Question: Condense the content of this figure into a single sentence.
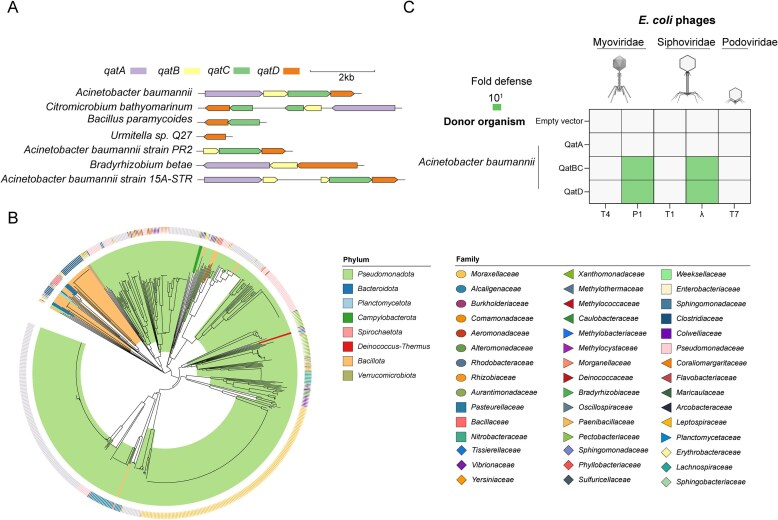
Answer: Qat anti-phage system is widespread. ( A ) The distribution and arrangement characteristics of the qat gene cluster and the scale bar (2 kb) denotes the length range of the gene cluster. Visualization was performed using ChiPlot ( https://www.chiplot.online/ ). ( B ) The phylogenetic analysis results of QatD homologs across representative bacterial species. This circular phylogenetic tree uses sector colors to distinguish bacterial Phylum, while the color bars at the branch termini correspond to the more refined family (different colors and symbols in the legend denote phylum and family). ( C ) Heatmap showing fold defense of E. coli expressing Qat components (empty vector, QatA, QatBC, QatD) against phages λ, P1, T1, T4, and T7. Green indicates a 10-fold increase in resistance, all assays were performed in triplicate.